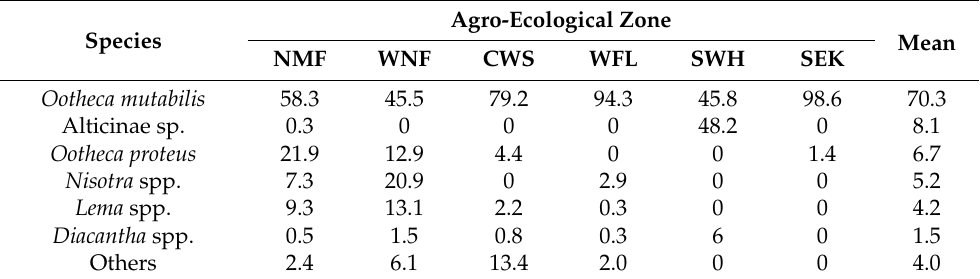
Table 2. Relative abundance (%) of leaf beetles in Ugandan agro-ecological zones from 2016 to 2017. Agro-Ecological Zone Species Mean NMF WNF CWS WFL SWH SEK Ootheca mutabilis 58.3 45.5 79.2 94.3 45.8 98.6 70.3 Alticinae sp. 0.3 0 0 48.2 8.1 Ootheca proteus 21.9 Nisotra spp. 2.9 0 0 5.2 Lema spp. 9.3 13.1 2.2 0.3 0 0 4.2 Diacantha spp. 0.5 1.5 0.8 0.3 1.5 Others 2.4